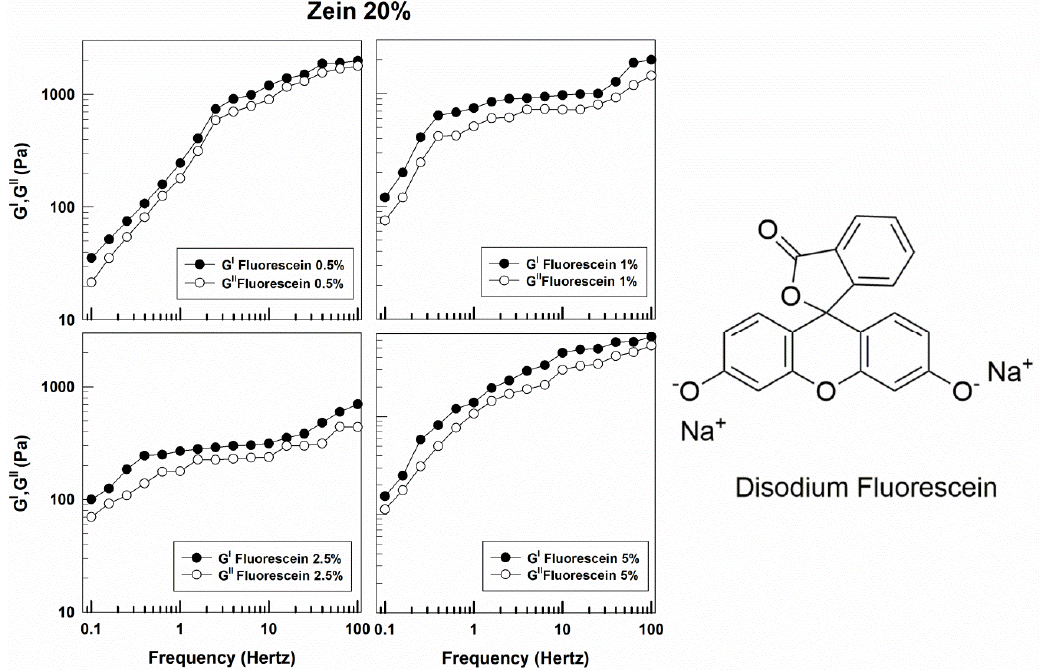
Figure 2. Evaluation of the elastic (G ′ ) and viscous (G ′′ ) moduli of zein gels prepared using 20% w/v of protein and containing disodium fluorescein (0.5%, 1%, 2.5%, 5% w/w ) as a function of the frequency.